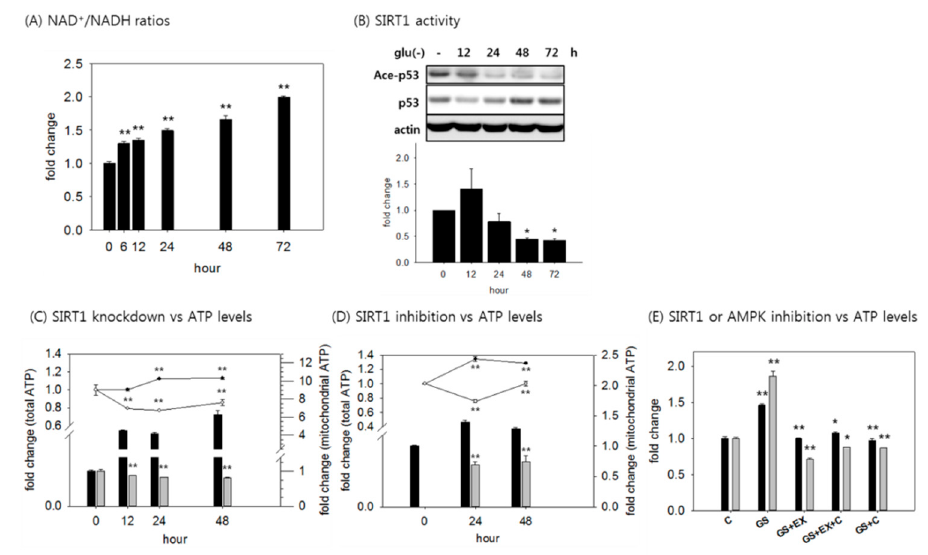
Figure 3. An increase in mitochondrial ATP production was mediated by the activation of SIRT1 and AMPK. ( A ) The cellular NAD+/NADH ratio was determined by measuring NAD+ and NADH levels at the indicated times; ( B ) Cells were deprived for glucose for 72 h, and then subjected to immunoblotting with antibodies against acetylated-p53 and p53. The activity of SIRT1 was calculated and represented as the ratio of acetylated-p53 to total p53 protein level; ( C ) Total ATP and mitochondrial ATP production levels. Cells were treated with nonspecific RNA (siCtrl) or siSIRT1 RNA, and then incubated in the presence or absence of glucose for the indicated time period. To determine mitochondrial ATP production, cells were treated with both 1 μ M antimycin A and 1 μ M rotenone for the last hour. The glycolytic ATP level was subtracted from the total ATP level. The line plot shows total ATP level in the control (- ● -) or SIRT1-knocked down (- ○ -) cells, and the bar chart shows the mitochondrial ATP production level in the control (black bar) or SIRT1-knocked down (grey bar) cells; ( D ) Total ATP and mitochondrial ATP production were plotted as shown in ( C ). Cells were incubated in glucose-free medium with or without 10 μ M EX527 for 48 h, and lysed for the measurement of ATP levels; ( E ) Cells were incubated in glucose-free medium for three days, and treated with 10 μ M EX527 and 2 μ M compound C for the last 12 h. Black bar shows the total ATP level, and grey bar shows the mitochondrial ATP level. Averages of values from at least two biological repeats are plotted. Values are presented as mean ± s.d. * p < 0.05, ** p < 0.01 by ANOVA.